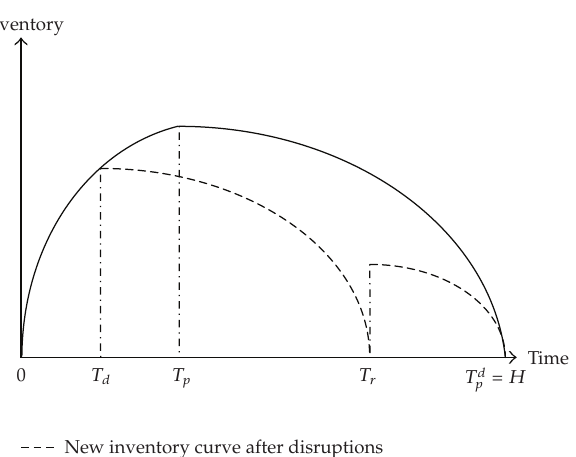
Figure 4: Inventory system (cid:5) T d